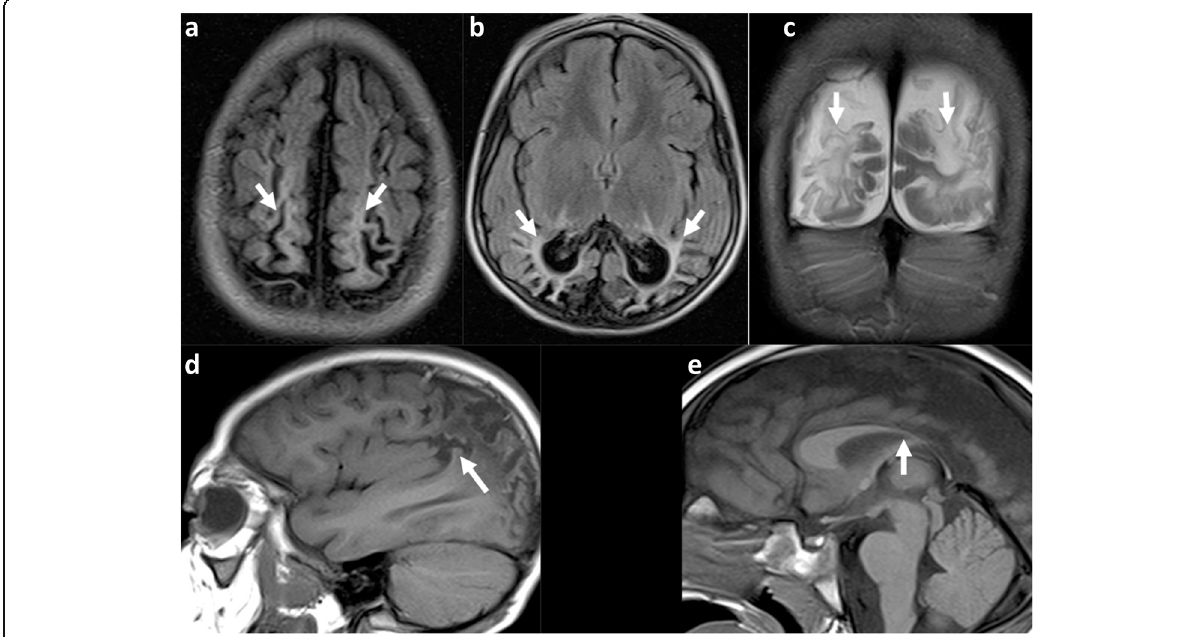
Fig. 7 a – e Peri-Sylvian and posterior watershed injury in a 4-year-8-month boy. a , b Axial FLAIR images at two different levels which not only demonstrate the peri-Sylvian and posterior watershed distribution of the atrophy (arrows) but also demonstrate the underlying white matter signal abnormality up to the ventricular edge, with white matter volume loss. c Coronal T2-weighted imaging confirms the atrophy and signal abnormality of the posterior watershed in another plane (arrows) and demonstrates relative sparing of the occipital lobes just above the tentorium. d Sagittal T1-weighted image demonstrates the peri-Sylvian distribution of atrophy (arrow). e Sagittal midline T1 shows the marked volume loss of the posterior body, isthmus, and splenium of the corpus callosum (arrow) corresponding to cortical and white matter volume loss in the posterior